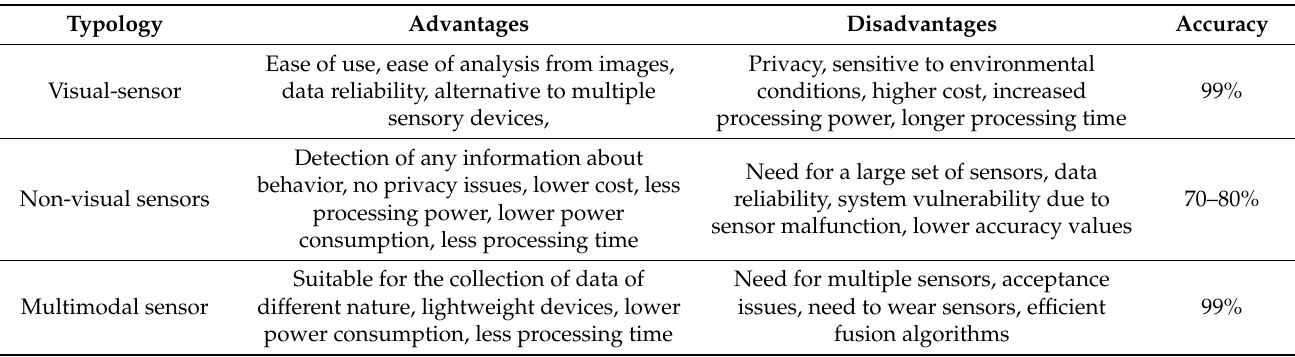
Table 4. Comparison of HAR technologies.